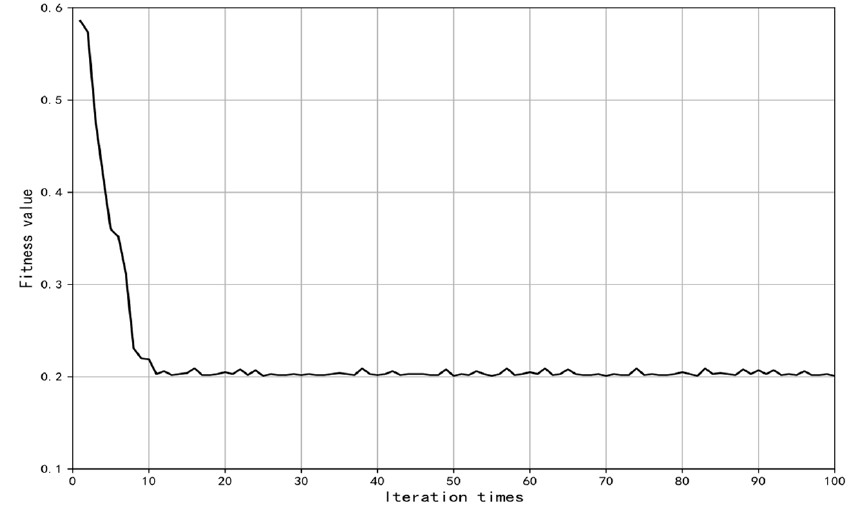
Figure 8. GWO optimization iterative curve.